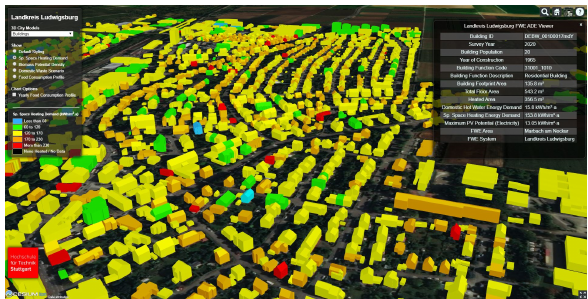
Figure 7. Marbach’s building stock heat energy demand visualisation